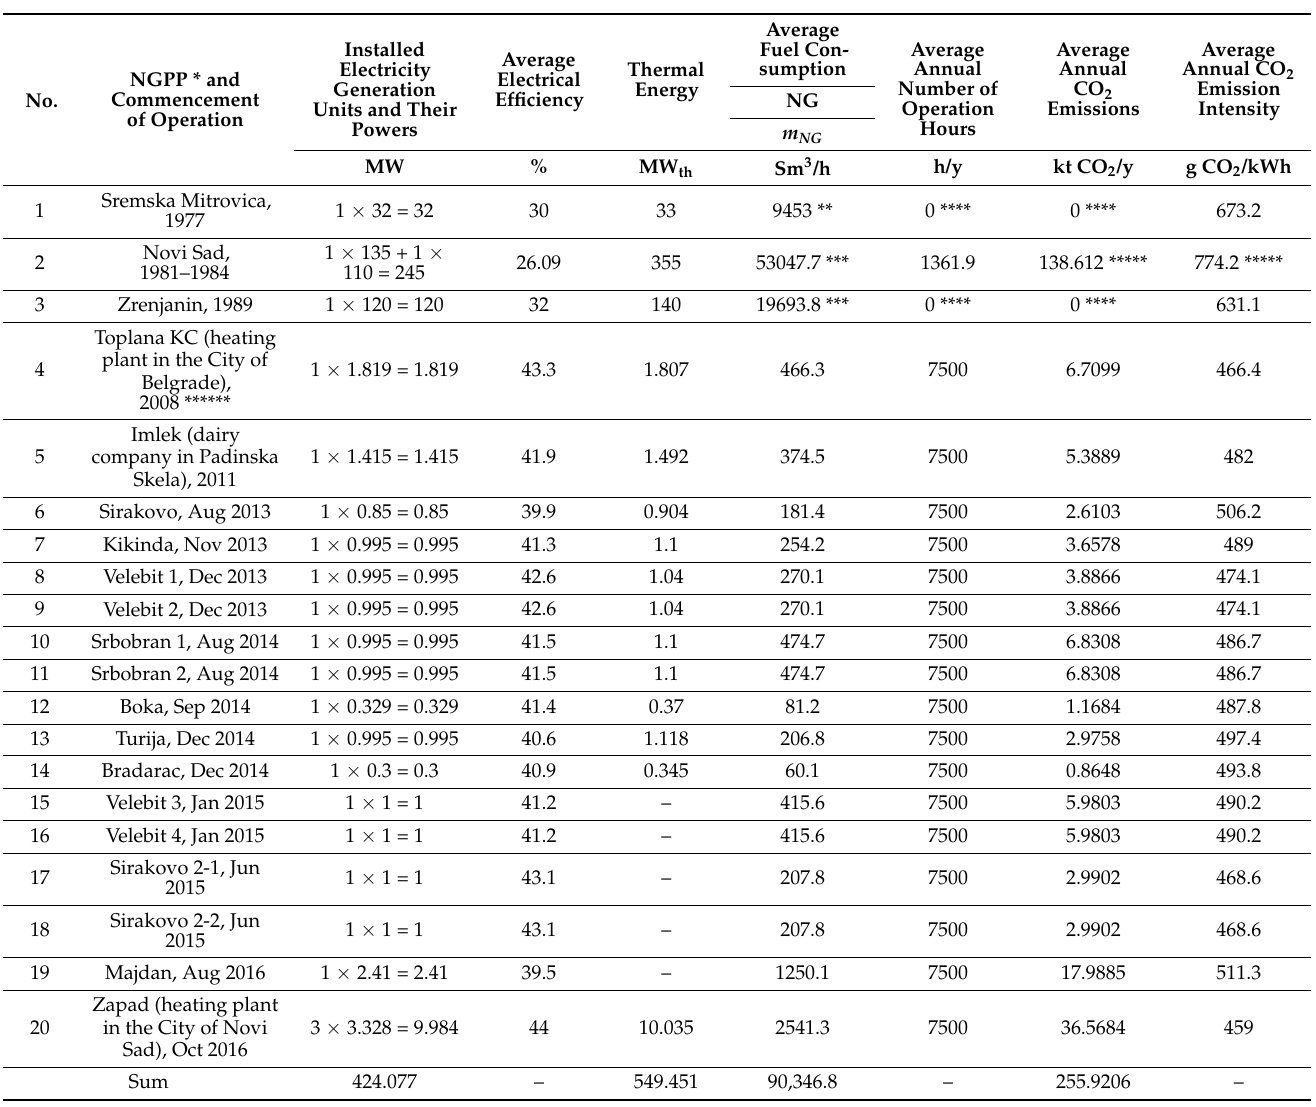
Table A3. An overview of the average performance indicators, average annual CO 2 emissions, average annual CO 2 emission intensities, and some other related information for the existing Serbian NGPPs